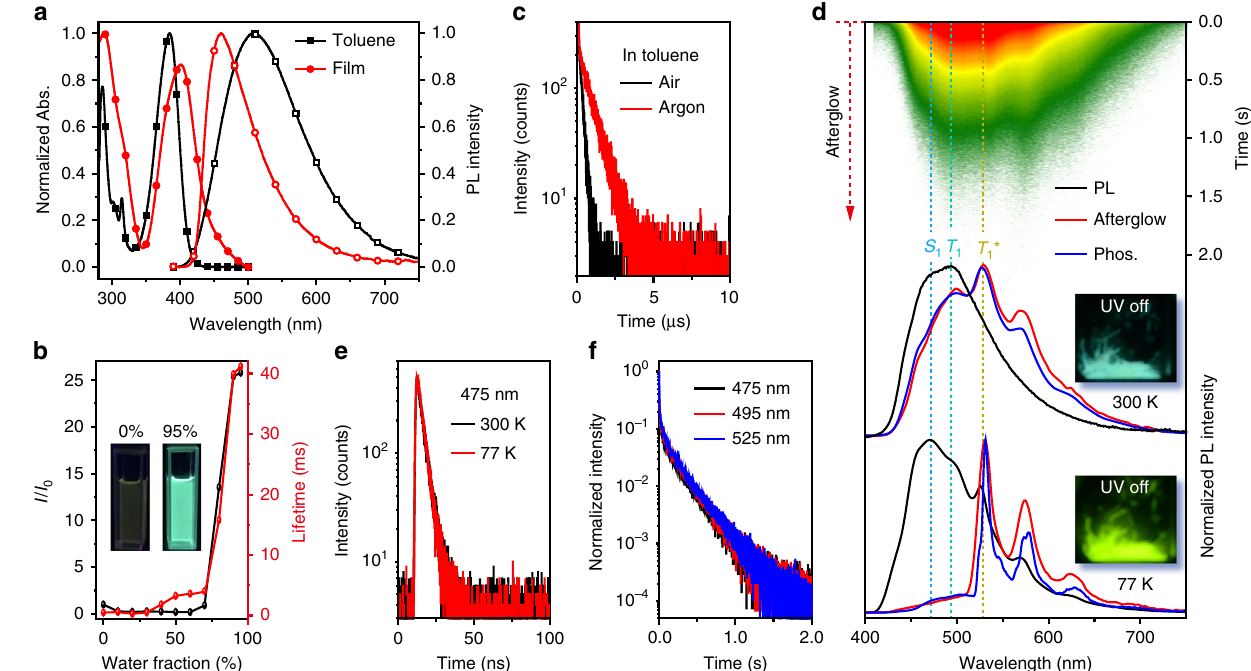
Fig. 2 Photophysical properties of DCzB. a Absorption and steady-state PL spectra of DCzB in dilute toluene solution and fi lm states. b Plot of PL intensity ratio ( I / I 0 ) and PL lifetime versus water fraction in the THF solvent, where I 0 is the PL intensity in pure THF and the insets are the photographs of DCzB solution with 0 and 95% water under 365 nm excitation at room temperature. c Lifetime decay pro fi les (510 nm) of DCzB solution in air and argon. d Steady-state PL (black line), afterglow (red line, delay 100 ms), and phosphorescent spectra (blue line, delay 5 ms) of DCzB crystal at 300 and 77 K with corresponding photographs taken after the removal of the 365 nm excition source. The upper inset shows the transient PL decay image of the sample recorded at 300 K. e Fluorescence decay pro fi les of DCzB crystal at 300 and 77 K. f Afterglow decay pro fi les of the 475, 495, and 525 nm emission bands of DCzB crystal excited at 380 nm at room temperature. Source data are provided as a “ Source Data fi le ”